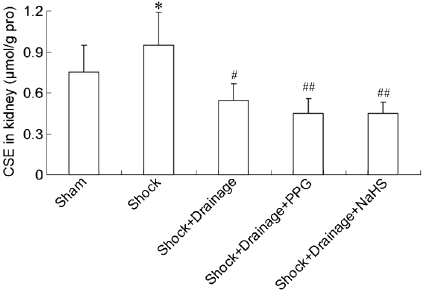
Figure 2. Changes in cystathionine- c -lyase (CSE) levels in rat kidneys. Data are reported as means±SD ( m mol/g protein, n=6). PPG: D,L-propargylglycine; NaHS: sodium hydrosulfide hydrate. *P , 0.05 vs the sham group; # P , 0.05, ## P , 0.01 vs the shock group (one-way